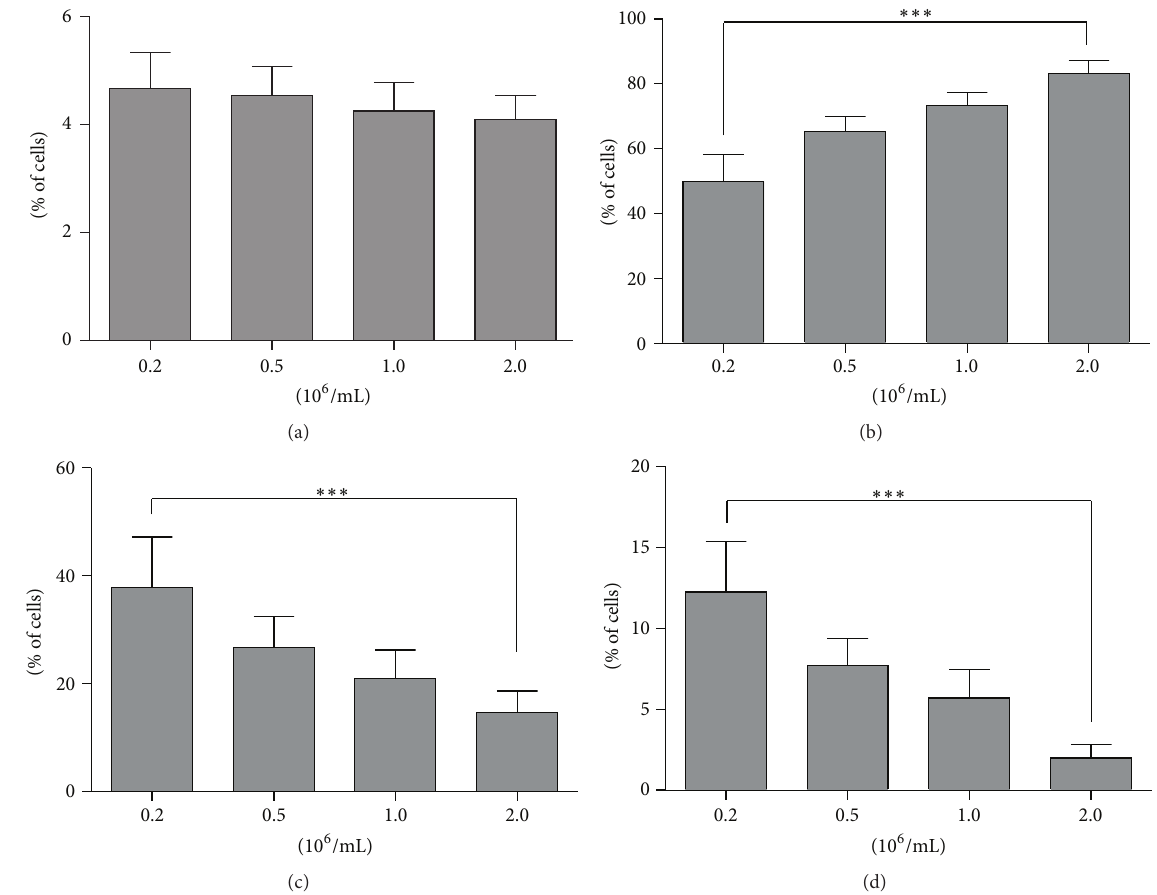
Figure 3: Effect of cell concentration on cell clumping and viability before transplantation. Fresh passage 5 rat BMMSCs were resuspended in 1mL DPBS with escalating concentrations of 0.2, 0.5, 1.0, and 2.0 × 10 6 /mL, respectively. (a) Cell clumps or large cells > 30 𝜇 m; (b)